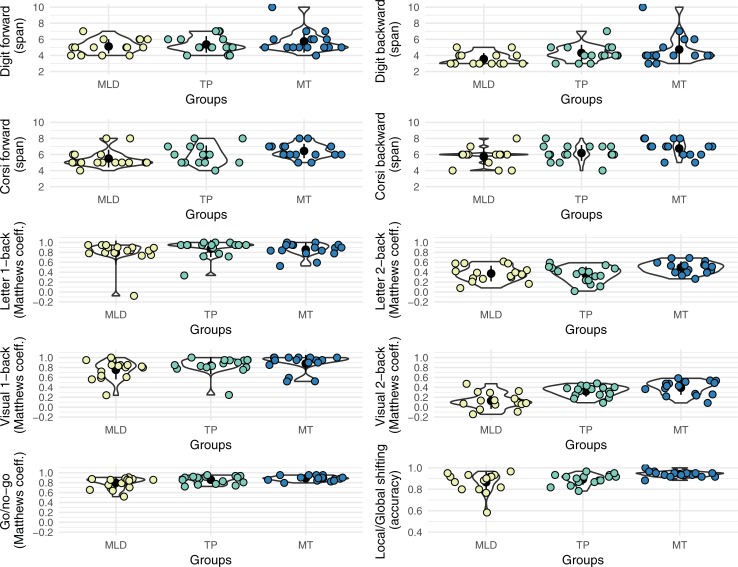
Violin plots for the two short-term memory and six executive function tasks.Each dot represents one participant. MLD = Mathematical learning difficulties, TP = Typical performance, MT = Mathematical talent.